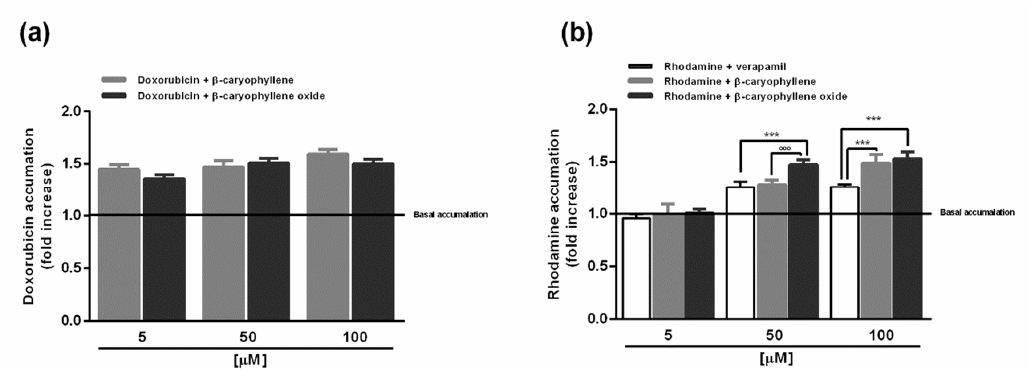
Figure 5. Effect of the sesquiterpenes β - caryophyllene and β - caryophyllene oxide on intracellular accumulation of doxorubicin ( a ) and rhodamine 123 ( b ) in HepG2 cells. The basal accumulation indicates that found in the vehicle control. *** p < 0.001 (t-Student test), significantly higher than verapamil. °°° p < 0.001 ( t - Student test), significantly higher than β - caryophyllene. Data represent the mean ± SE (standard error) of at least two experiments in which each treatment was tested in triplicate ( n = 6).